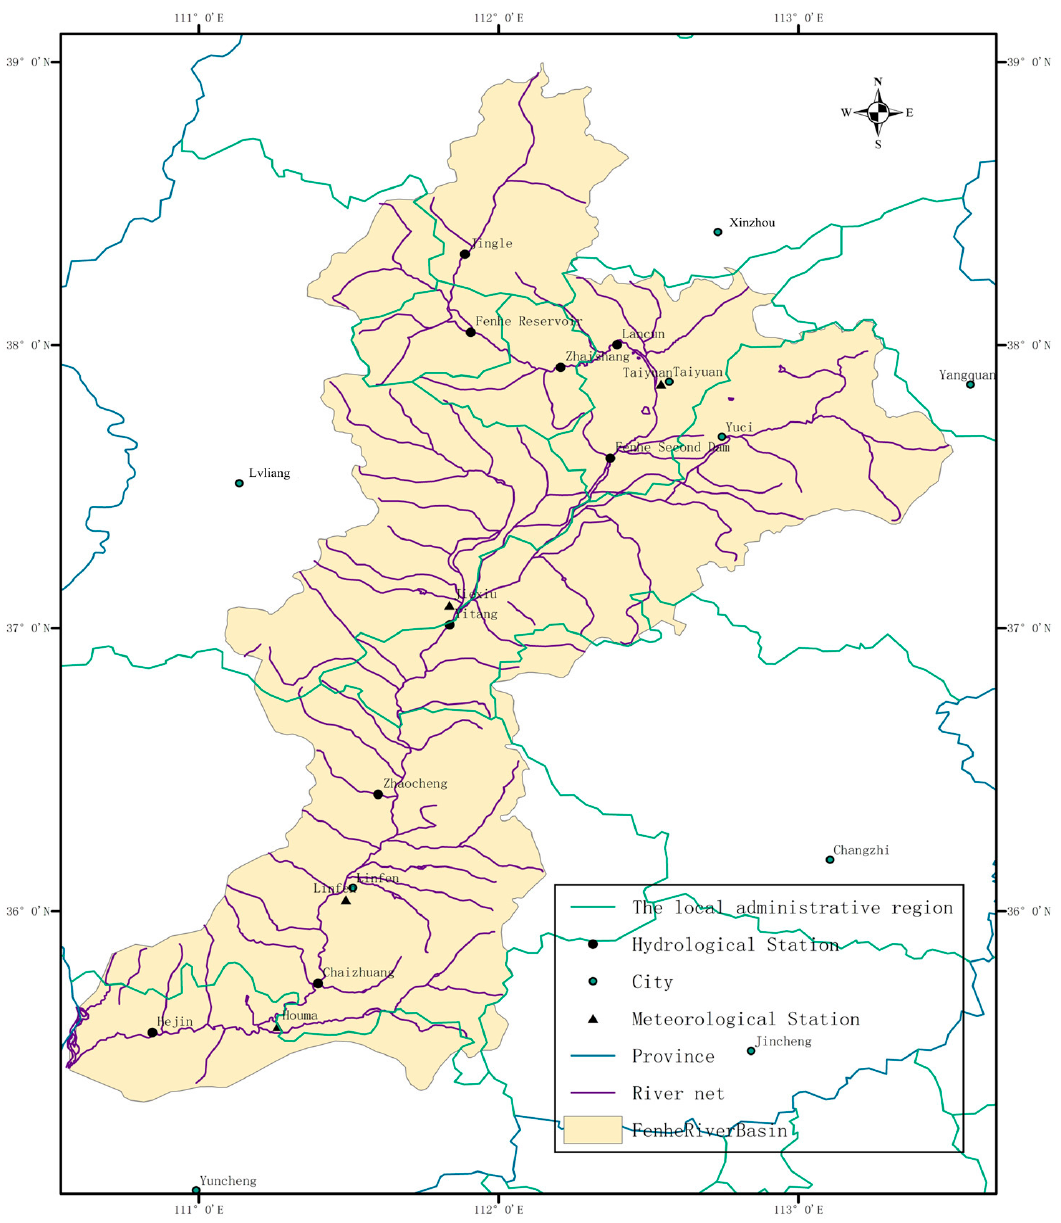
Figure 1. Water system in the Fenhe River basin.